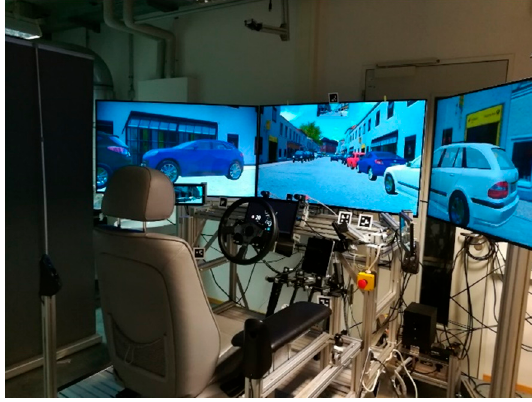
Figure 4. Mock-up used in this study.